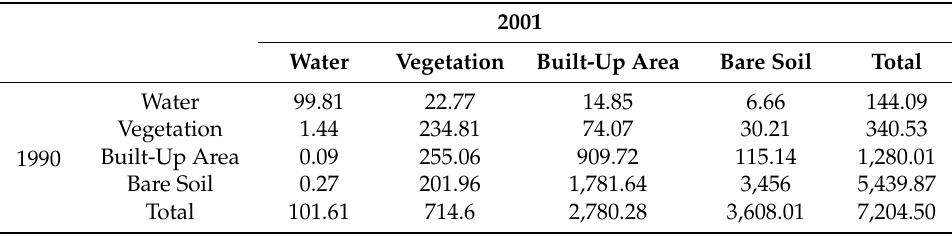
Table 6. Change detection matrix showing the class changes between 1990 and